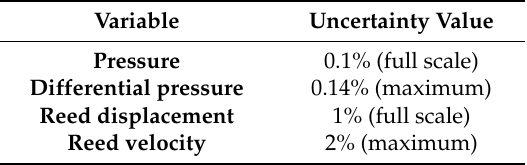
Table 2. Uncertainty of the measurement.